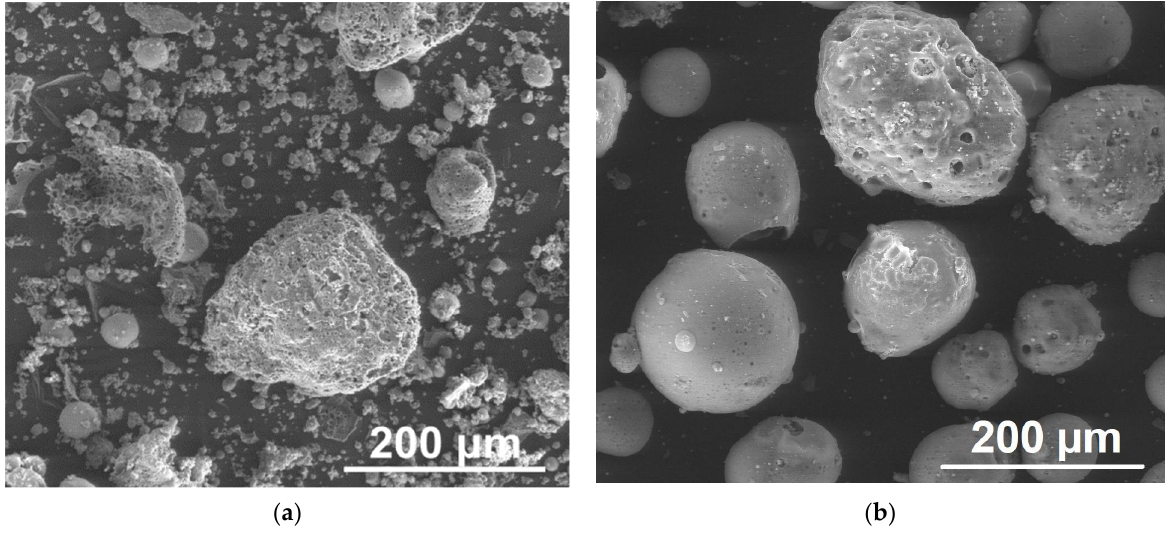
Figure 1. SEM images of FA ( a ) and M ( b ). Magnitudes ×350.